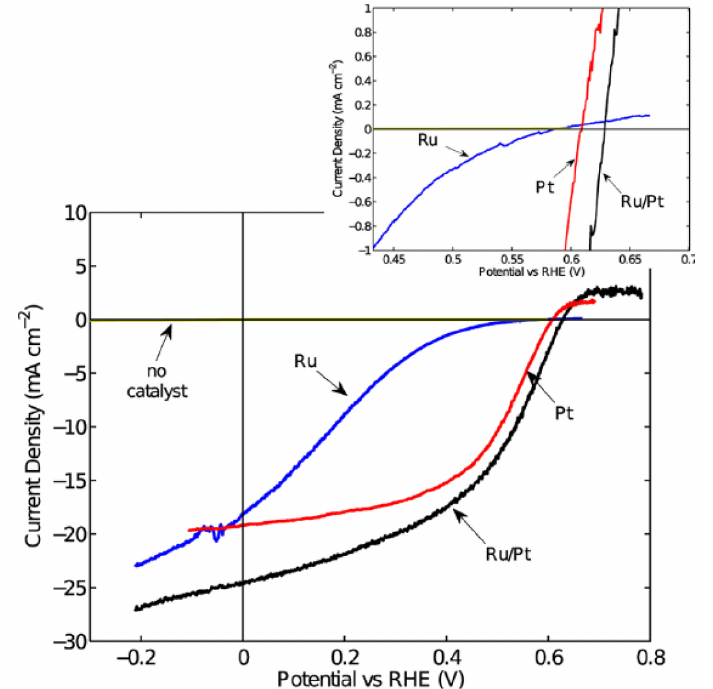
Figure 11. J–E behavior of the p-WSe 2 photoelectrodes generating H 2 from aqueous pH 4.2 electrolyte without catalyst coating and with Ru, Pt, or Ru/Pt coatings, respectively. All electrodes were illuminated using an ELH tungsten halogen lamp calibrated to an equivalent of 100 mW cm − 2 intensity using a Si photodiode. The inset is a detail of the region around the open-circuit potential of the photoelectrodes. Reproduced with permission from [155]. Copyright American Chemical Society,